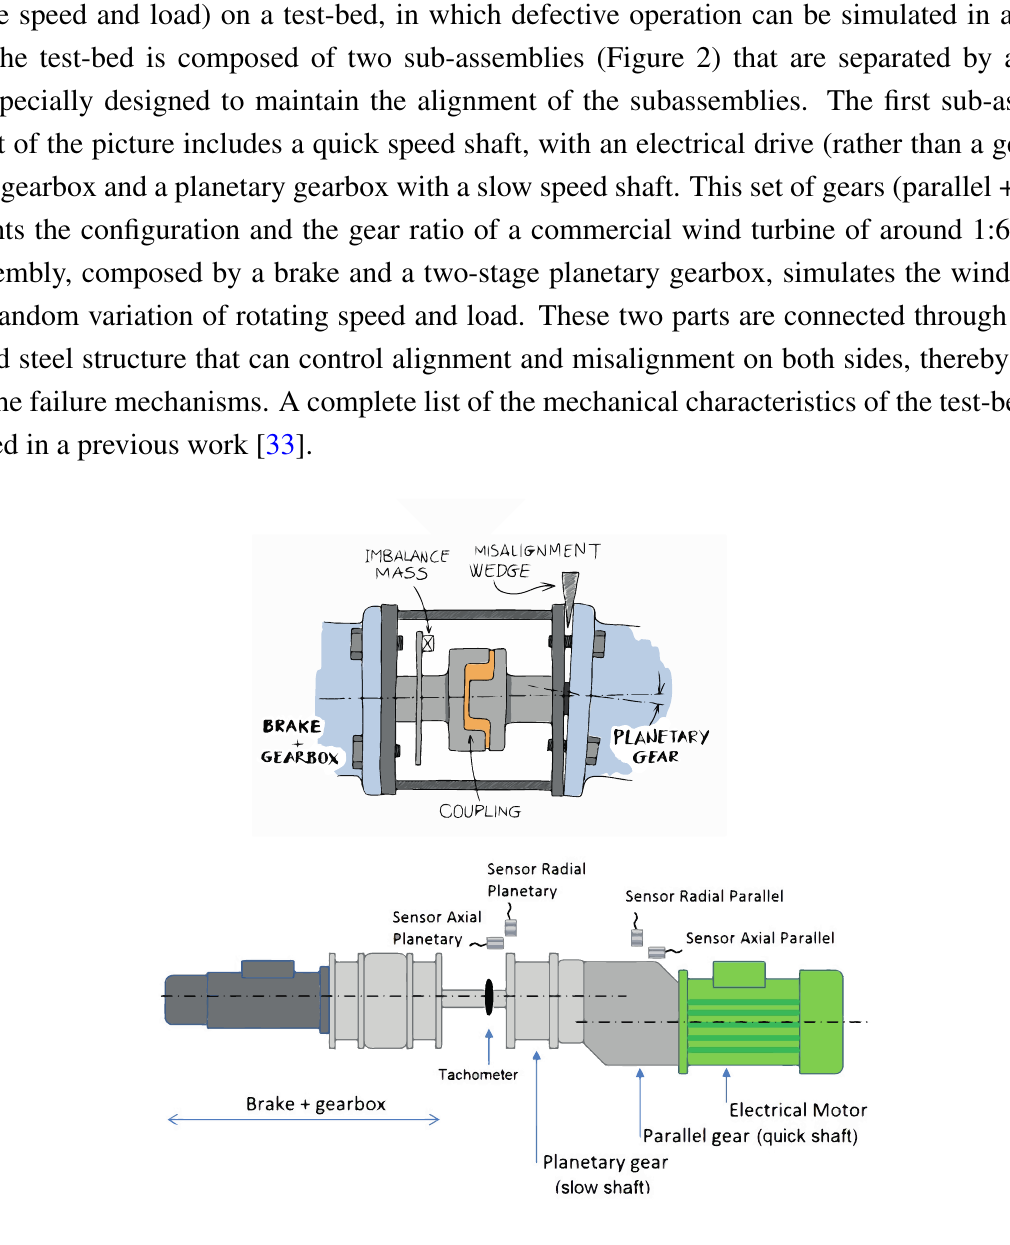
Figure 2. Scheme of the